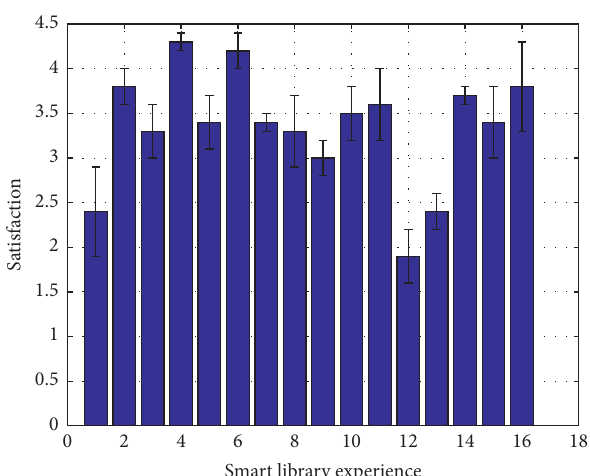
Figure 11: Histogram of satisfaction with various elements of user experience.